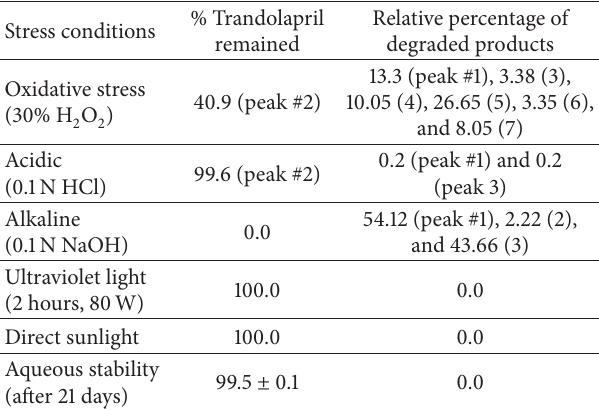
Table 6: Stability data under different stressed conditions. Stress conditions